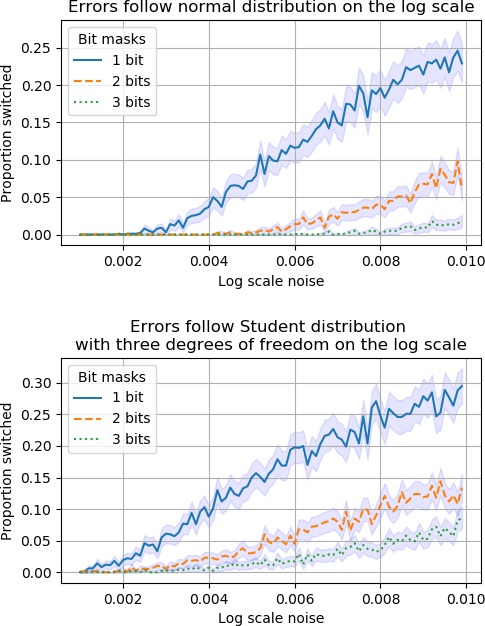
The fitness landscapes are additive and each mutation 0↦1 decreases fitness.The graphs compare replacements 0↦1,00↦11 and 000↦111. Because of measurement errors, some replacements appear to increase fitness. The graphs show the proportion of such cases.